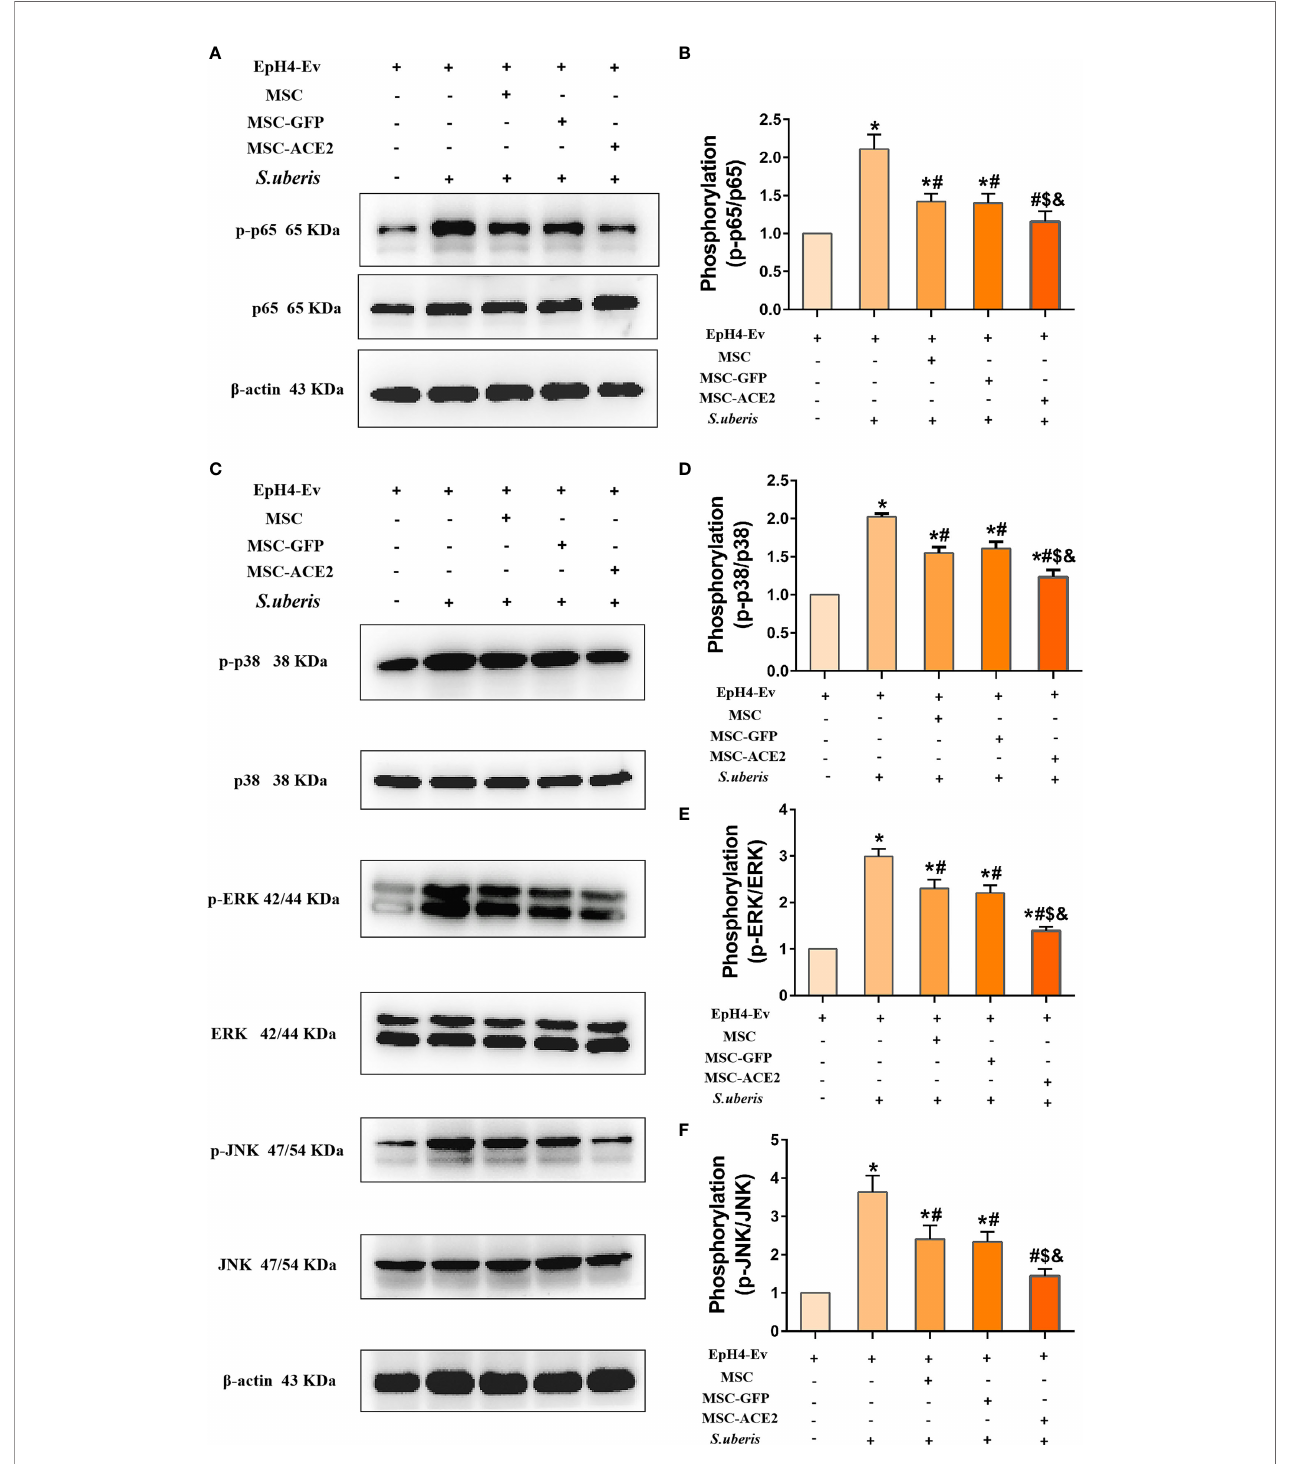
FIGURE 7 | Effect of MSC-ACE2 on NF- k B and MAPKs signaling pathways. (A) Detection of relative protein expression levels of p65 and p-p65 by Western blot. (B) Statistics of p65 and p-p65 Western blot results. (C) Detection of relative protein expression levels of p38, ERK, JNK, and p-p38, p-ERK, p-JNK by Western blot. (D-F) Statistics of p38, ERK, JNK, and p-p38, p-ERK, p-JNK Western blot results. Experiments were repeated three times and data were presented as the mean ± SEM (n = 3). * P < 0.05 vs. EpH4-Ev; # P < 0.05 vs. S. uberis ; $ P < 0.05 vs. MSC; & P < 0.05 vs.